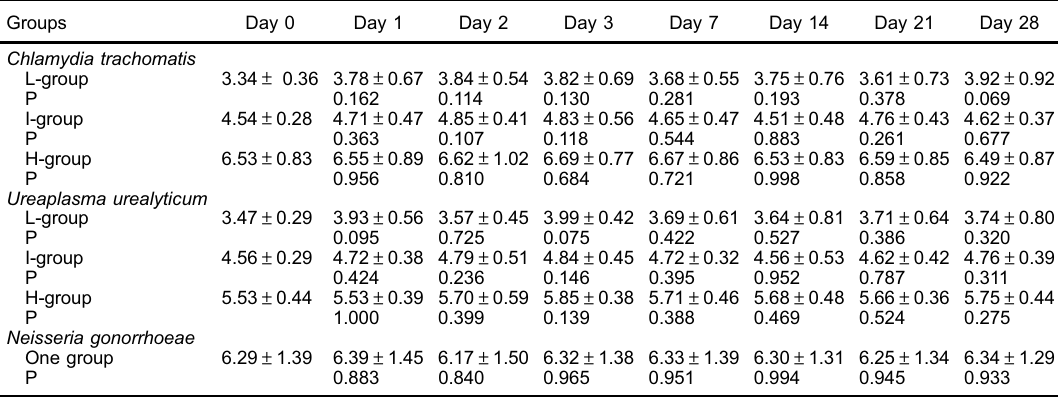
Table 2. DNA loads of the studied bacteria at different time points.